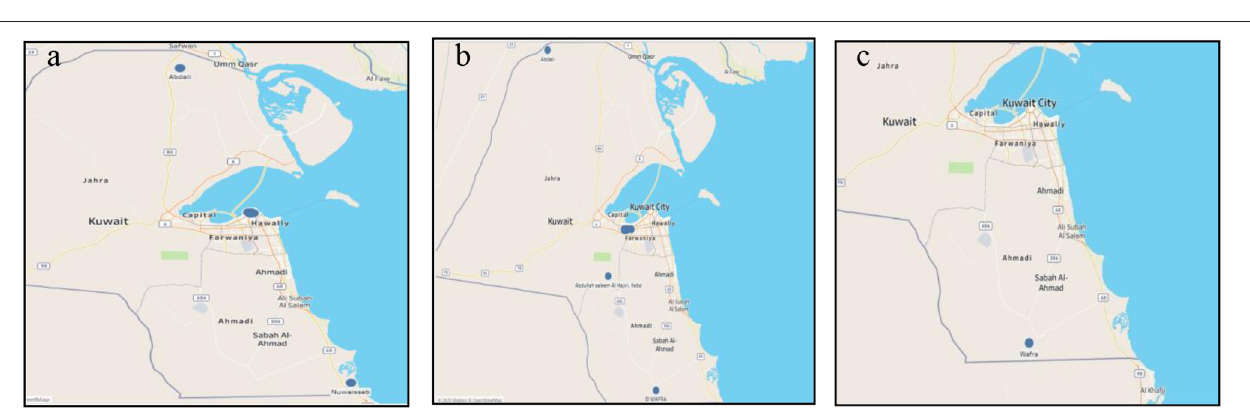
FIGURE 4 | Middle East respiratory syndrome coronavirus outbreaks (a) ; Foot and mouth disease outbreaks (b) ; Glanders outbreaks in Kuwait during the period 2005–2020 (c)